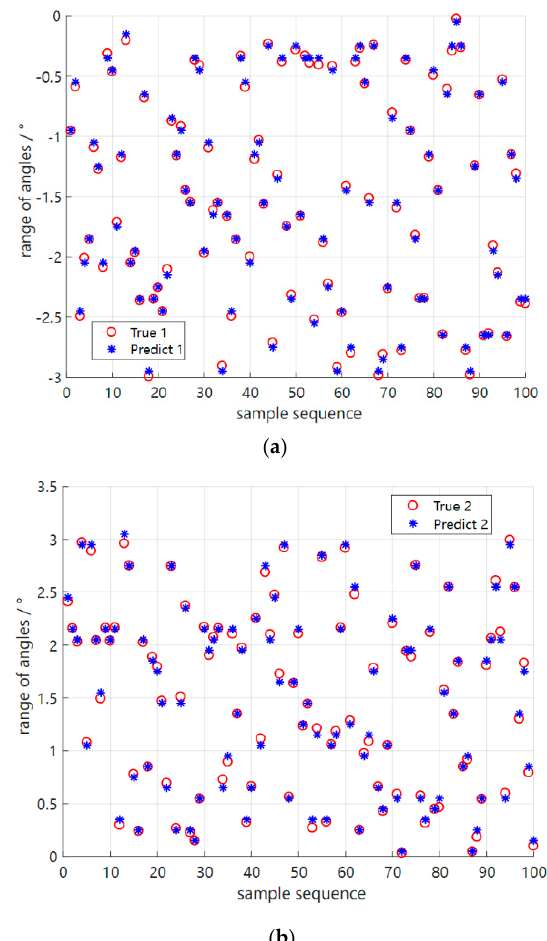
Figure 9. Error plots of the S2S network meta − reinforcement learning algorithm based on two perspectives in the original environment, respectively ( a , b ). ( a ) Error plot of the S2S network meta − reinforcement learning algorithm based on the first angle in the original environment. ( b ) Error plot of the S2S network meta − reinforcement learning algorithm based on the second angle in the original environment.